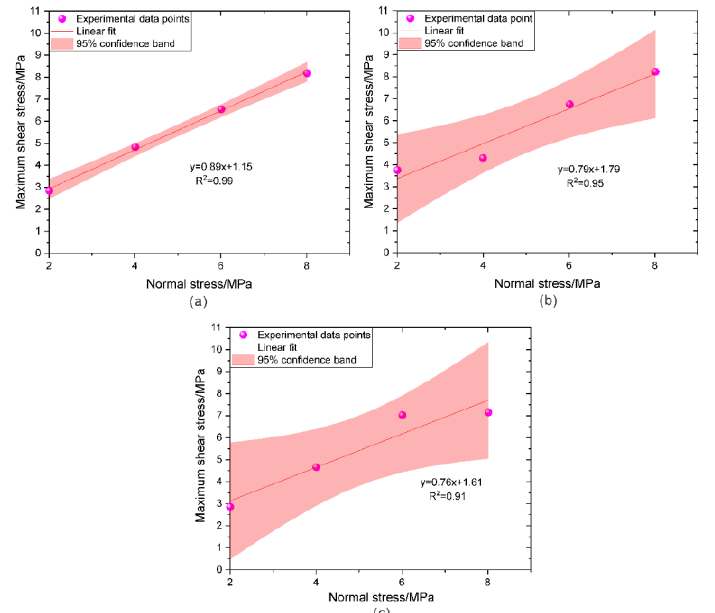
Figure 13. The linear fitting relationship between the shear strength and the normal stress of the fault rocks with three types of fault gouge (( a ) is No. 1 fault gouge, ( b ) is No. 2 fault gouge, ( c ) is No. 3 fault gouge) and shear fault plane. Table 4. Cohesion and friction angle obtained from the direct shear tests of two types of fault rocks filled by different types of fault gouge.